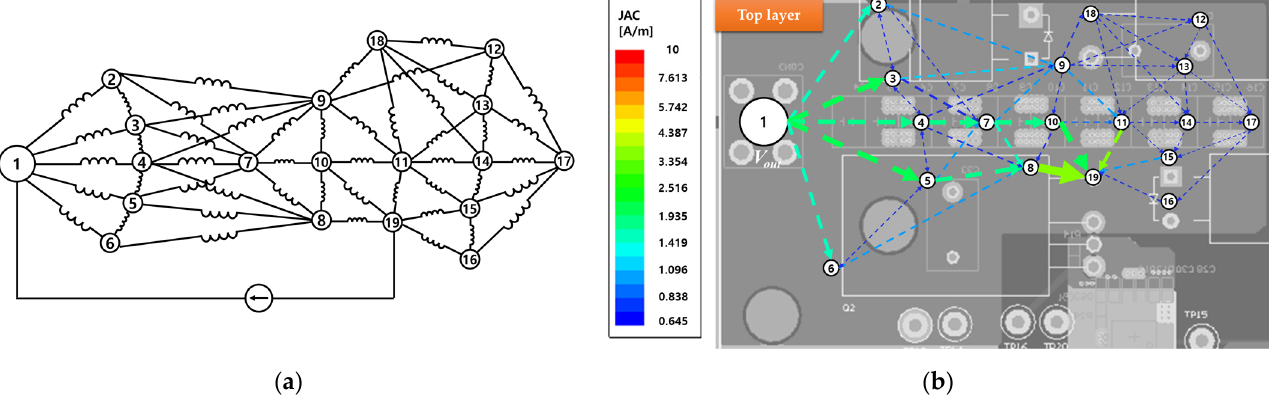
Figure 10. PSpice simulation at top layer. ( a ) Circuit model. ( b ) Simulation result.